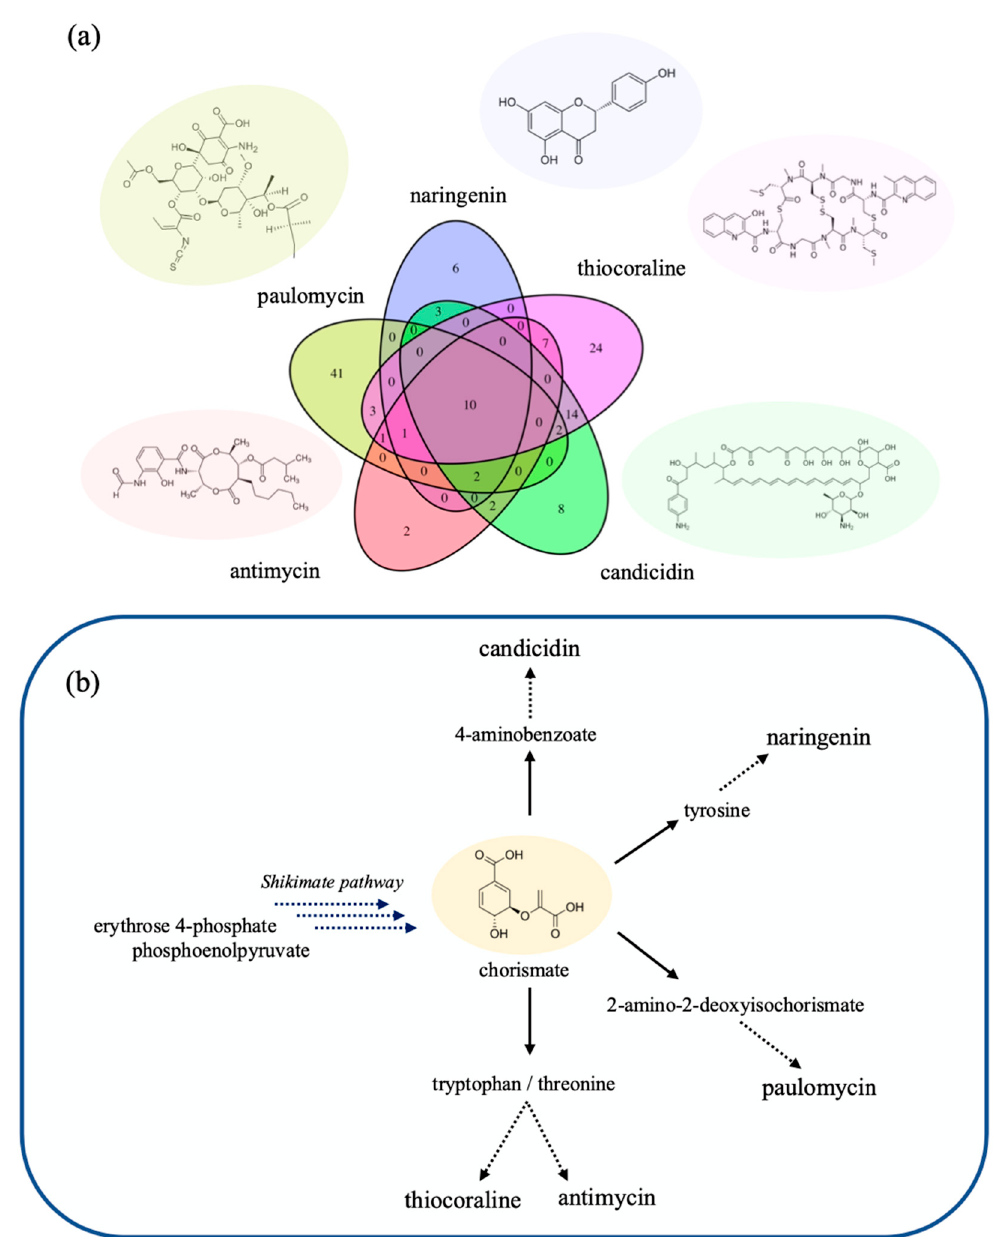
Figure 3. Overview of FSEOF to predict engineering targets for improved product synthesis. ( a ) a comparison of listed targets (reactions) predicted for each product and between how many targets the suggested targets are shared. Further details on reaction name, pathway and slope can be found in Table S3. ( b ) simplified view of pathways branching off from the shikimate pathway towards individual product targets. Each product draws from chorismate as a precursor.